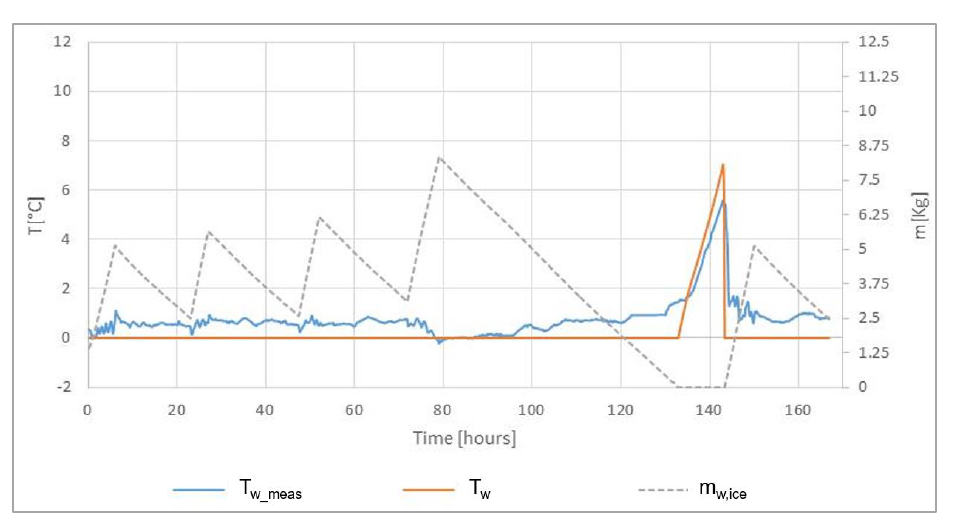
Figure 7. Comparison of the average water temperatures simulated and measured in the storage container during a typical working week, along with the amount of frozen water at every time step.